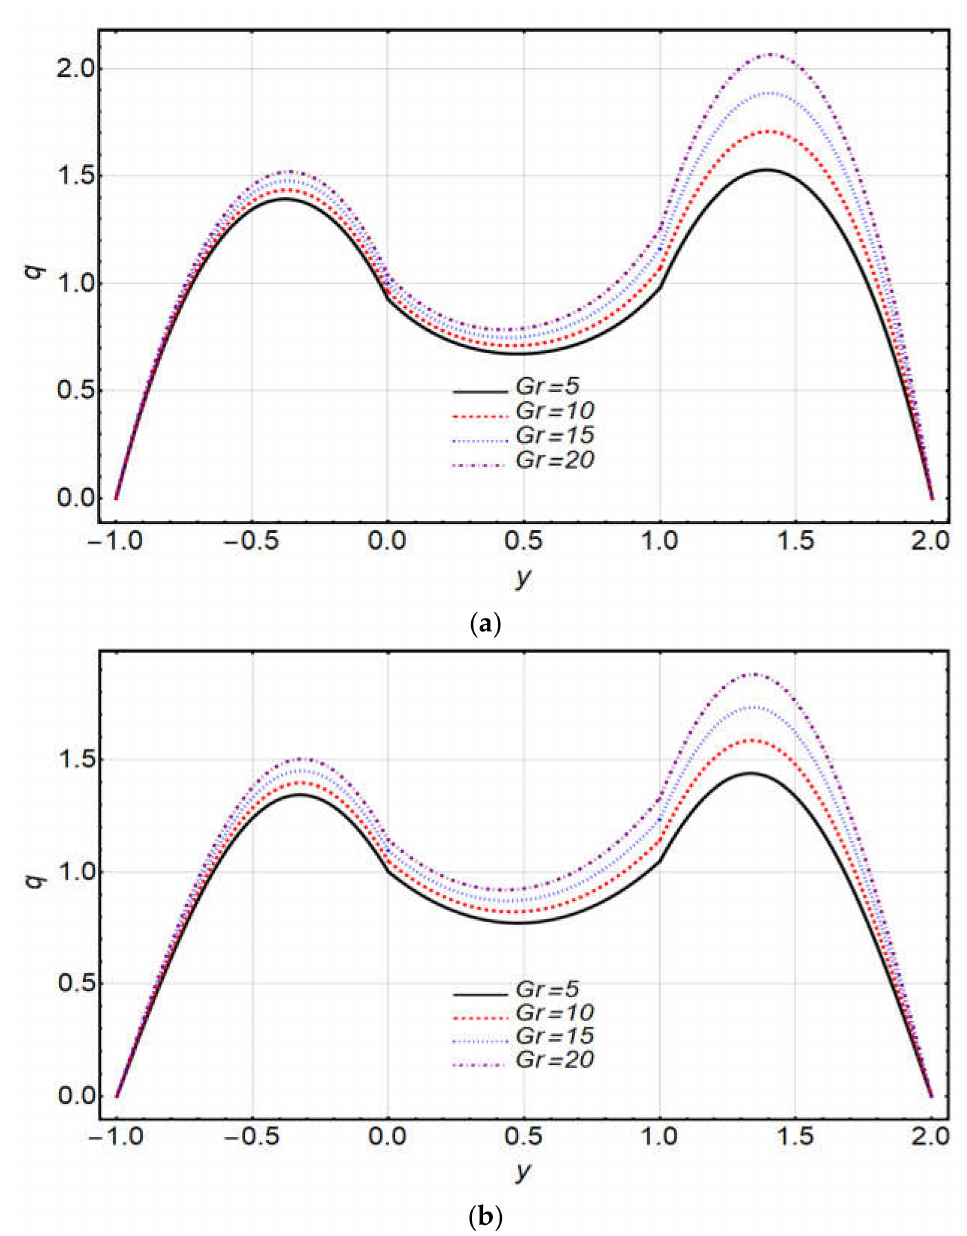
Figure 5. Velocity distribution of Gr : ( a ) axial, ( b )